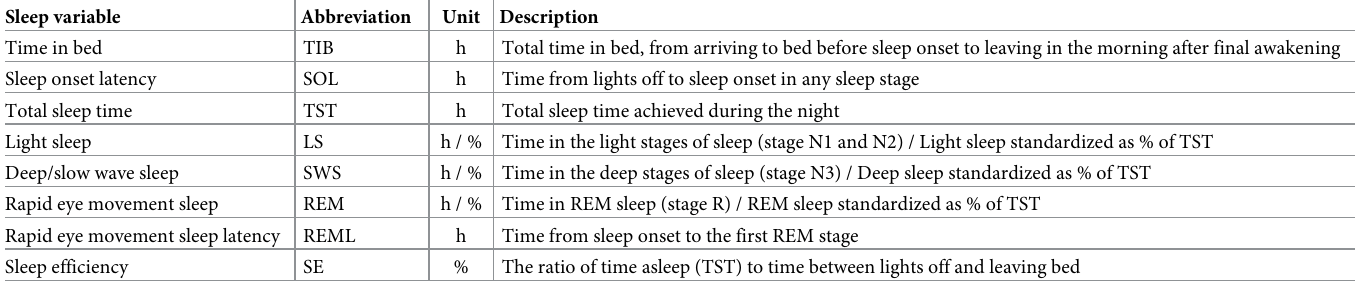
Table 1. Descriptions of the sleep variables collected with the Somnofy sleep monitor.